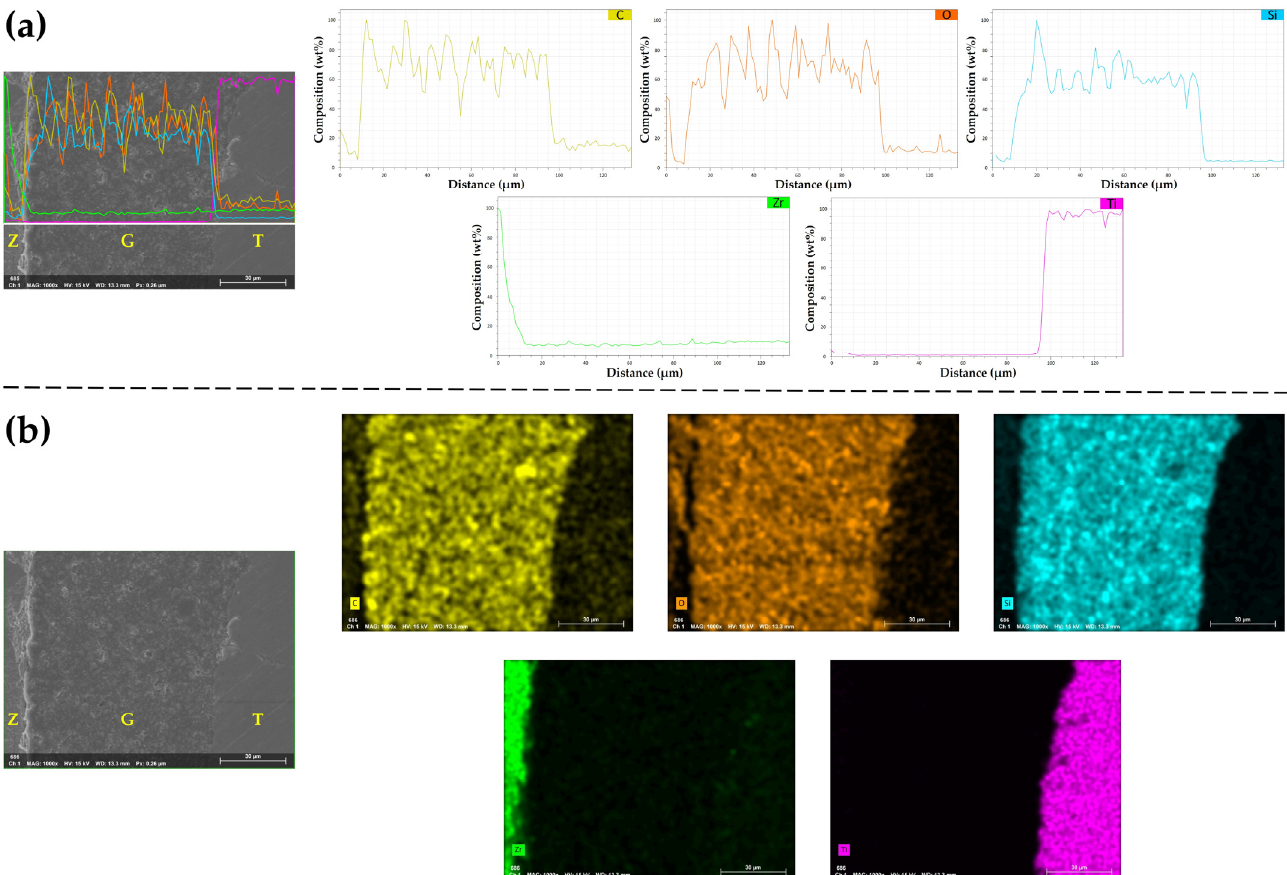
Figure 12. Line scan analysis and elemental mapping analysis at the same cross-sectional bonding interface for the NTP group in thermocycling. ( a ) Line scan analysis shows the distribution of each element along the white straight line marked in the FE-SEM image. ( b ) Elemental mapping analysis shows the presence of each element through color differences. Z, Zirconia surface. G, G-CEM LinkAce. T, Titanium abutment. C, Carbon. O, Oxygen. Si, Silicon. Zr, Zirconium. Ti, Tita- nium.